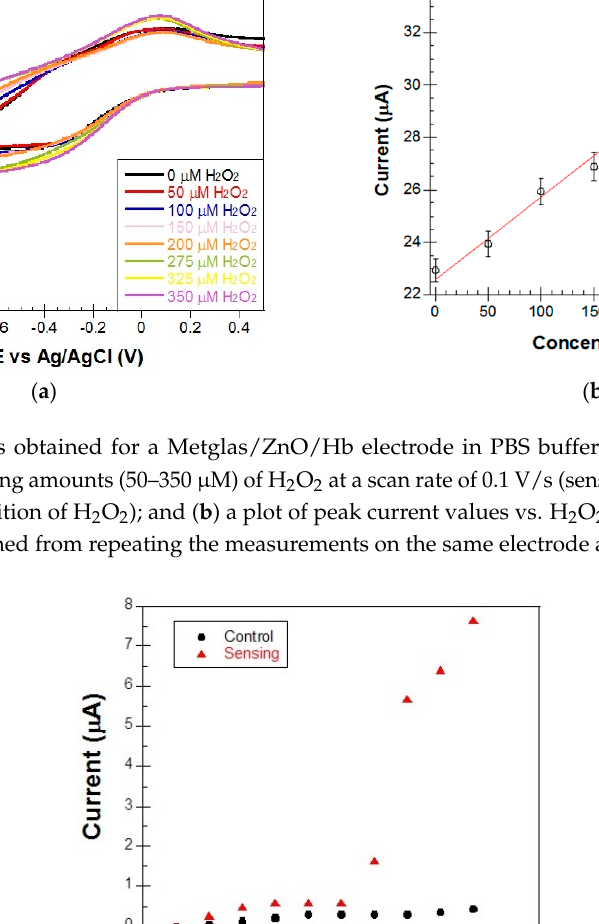
Figure 13. Comparison of the control peak current (circles) obtained from the CVs of a